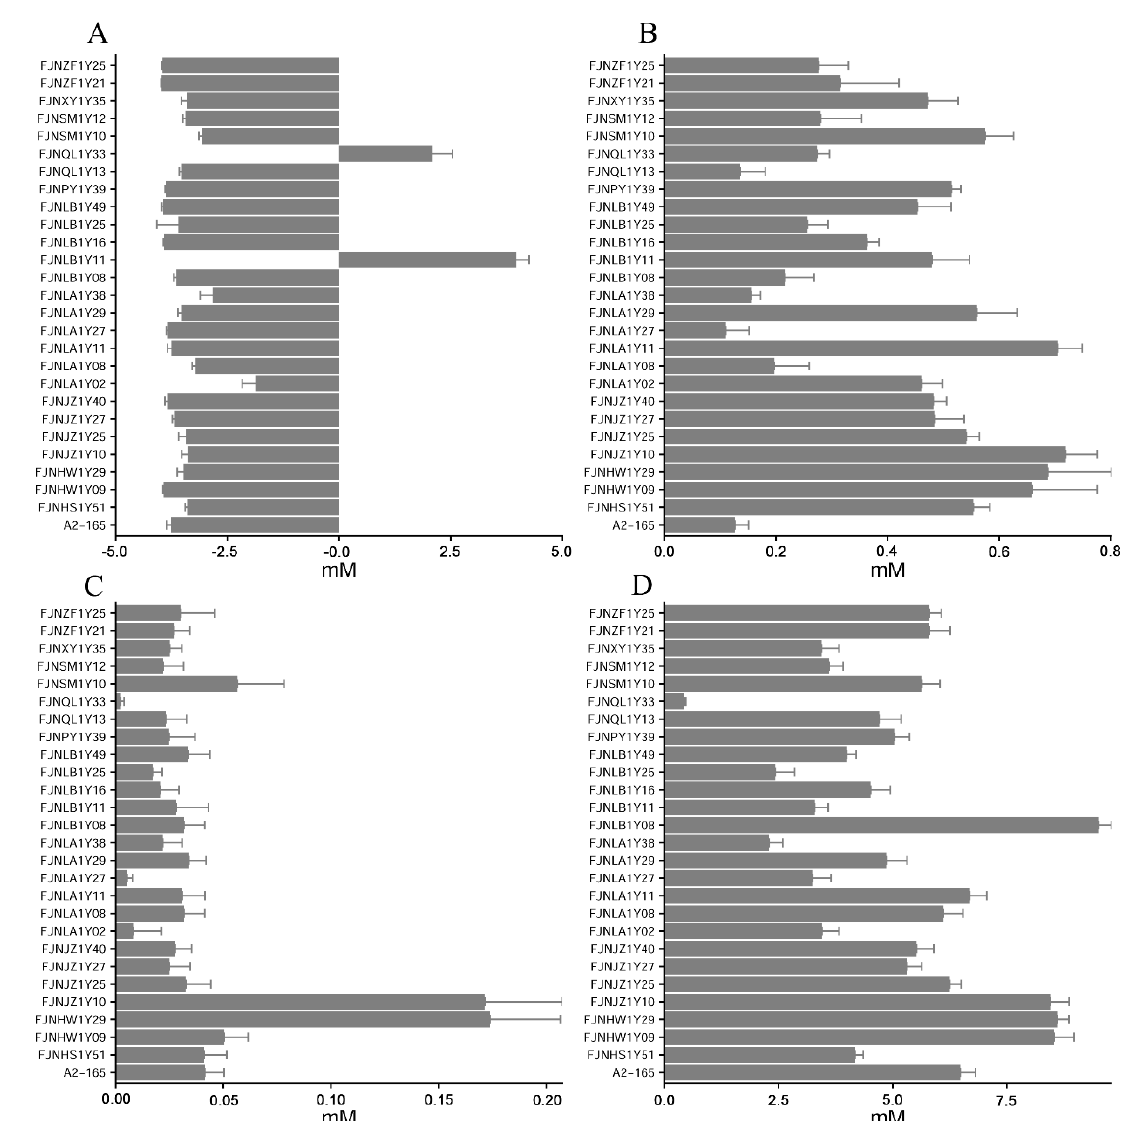
Figure 5. SCFAs production of F. prausnitzii strains in the cultural media. ( A ) Acetic acid concentration; ( B ) propionic acid concentration; ( C ) iso-butyric acid concentration; ( D ) butyric acid concentration.